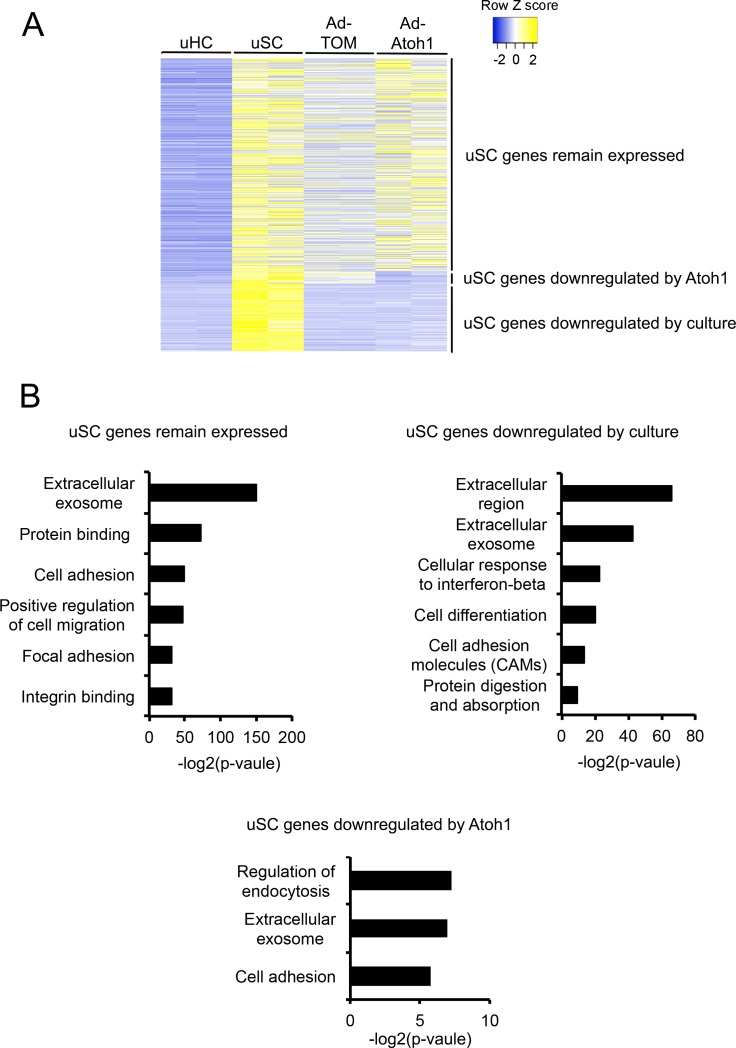
Down-regulation of supporting cell genes in Atoh1 infected supporting cells.(A) Heat map comparing gene expression level for all 2619 supporting cells enriched genes between intact hair cells, supporting cells and supporting cells from utricles either cultured and exposed to 0.1 mM gentamicin in the presence or absence of Atoh1 virus. Genes were divided into three group based on their relative expression in viral infected groups compared with supporting cells: supporting cell genes that remain expressed with Atoh1 transduction; supporting cells genes that are down-regulated by damaging and transduction with Atoh1; supporting cell genes that are down-regulated by damage alone. (B) Gene ontology analysis of enriched pathways or keywords in the three classes of supporting cell genes identified by clustering.